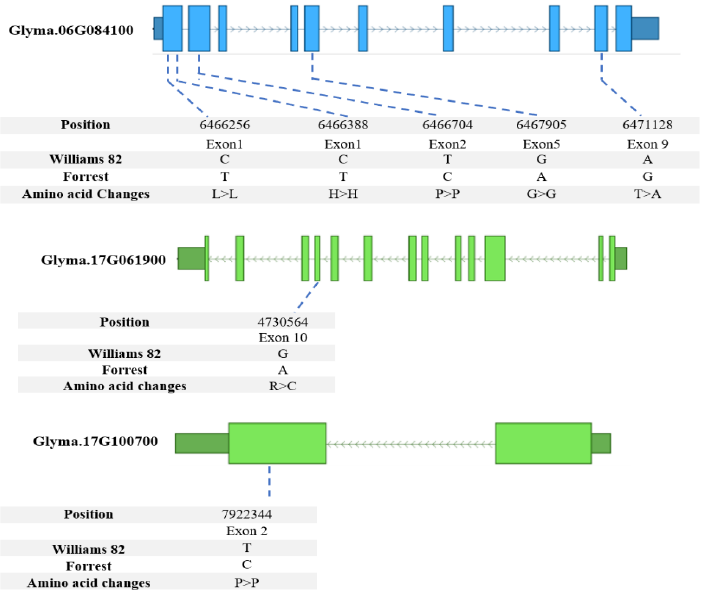
Figure 4. Positions of SNPs between Forrest and Williams 82 cultivars in Glyma.06G084100, Glyma.17G061900 and Glyma.17G100700 coding sequences. In the gene model diagram, the light blue/light green boxes represent exons, blue/green bars represent introns, dark blue/dark green boxes represent 3 (cid:48) UTR or 5 (cid:48) UTR. SNPs were positioned relative to the genomic position in the genome version